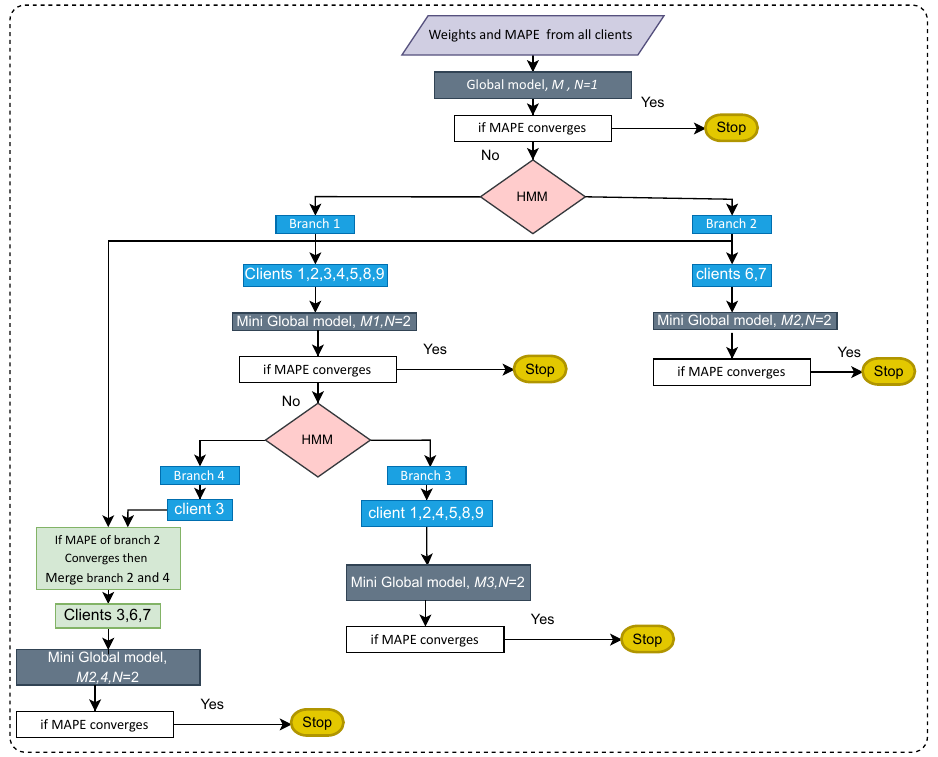
Figure 14. Graphical elaboration of FedBranched on considered example. Table 1. MAPE comparison of traditional FL and